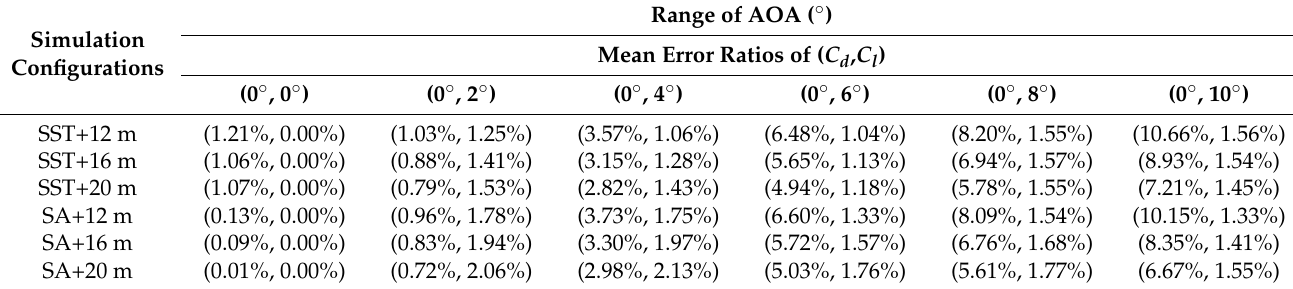
Table 12. The mean error ratios of C d and C l of the sharp trailing edge based on definition formula applying 264